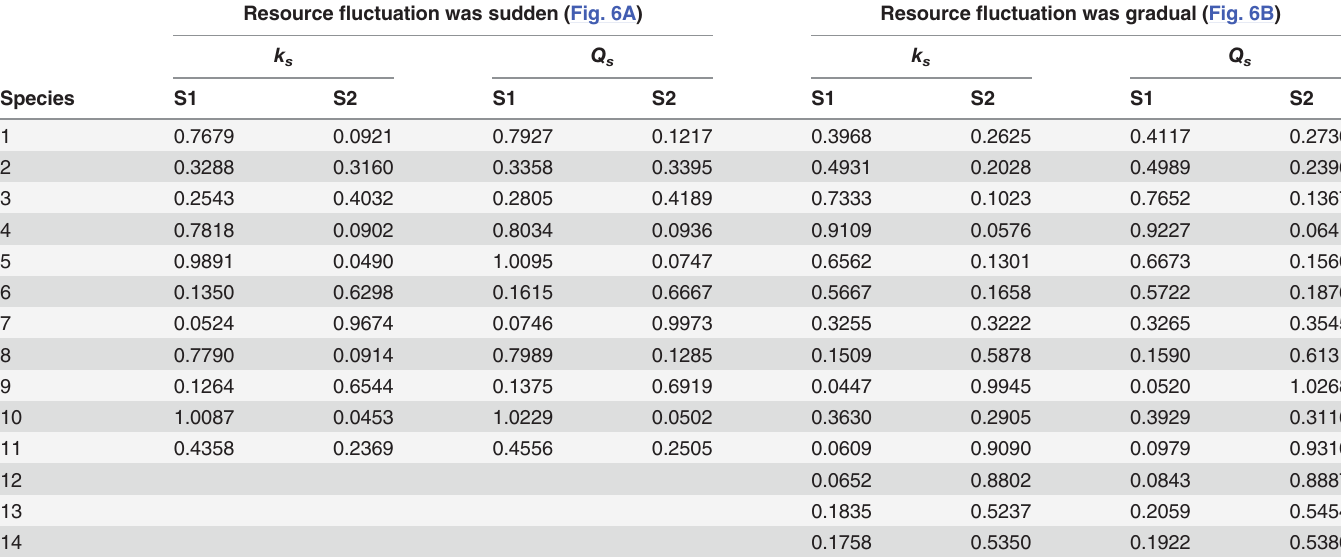
Table 2. Life history traits ( k s and Q s for resources S1 and S2) of species from representative simulations shown in Fig. 6.